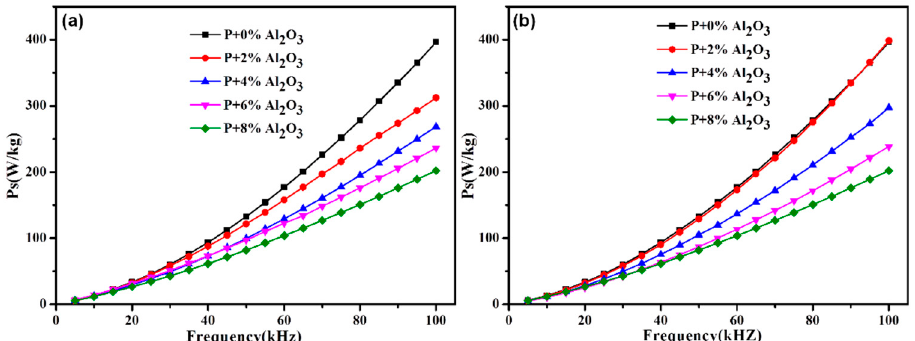
Figure 9. The total core loss of the hybrid-coated samples prepared by ( a ) ball milling and ( b ) sol–gel with the same addition amount of Al 2 O 3 .